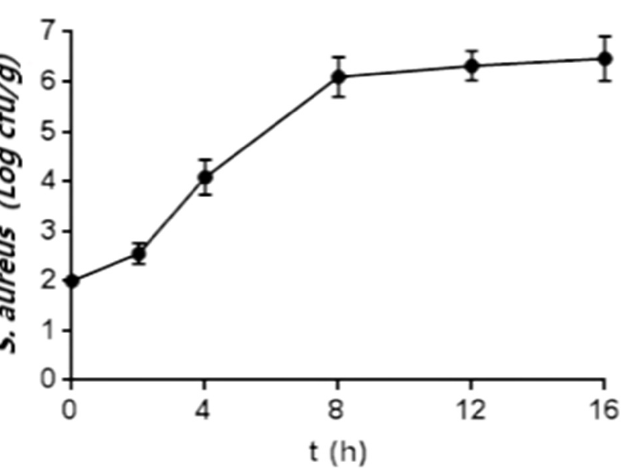
Figure 2. Growth curve of S. aureus in fermenting wholewheat sourdough ( n = 6).